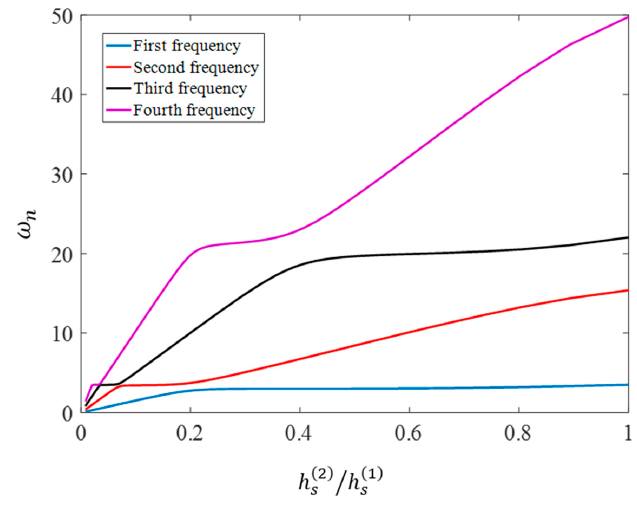
( 1 ) ( 2 ) (cid:3046)((cid:2870)) ℎ (cid:3046)((cid:2869)) (cid:3415) . s s / h